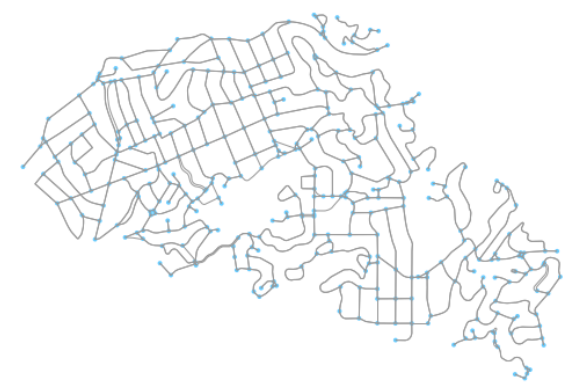
Figure 1: Output from codebox